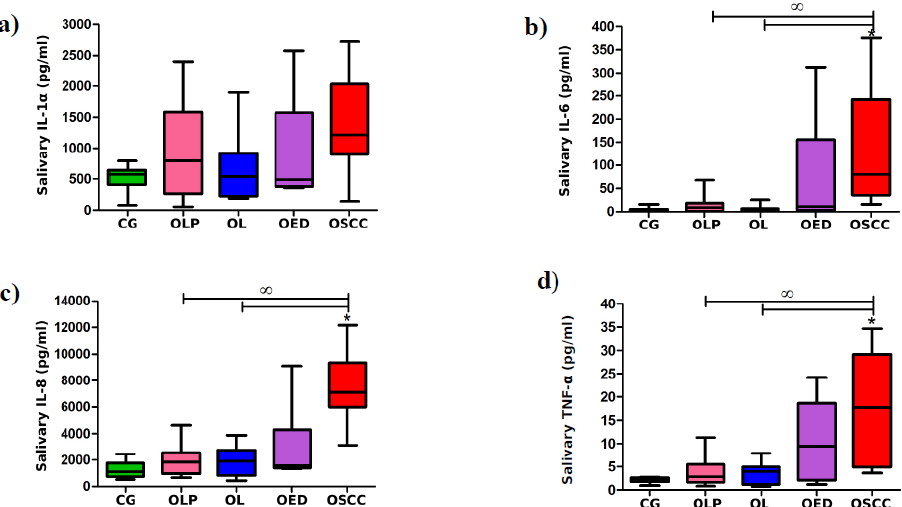
Figure 9. Salivary levels of IL-1 α ( a ), IL-6 ( b ), IL-8 ( c ), and TNF- α ( d ) in control group (CG) and patients with oral lichen planus without dysplasia (OLP), oral leukoplakia without dysplasia (OL), oral epithelial dysplasia (OED), or oral squamous cell carcinoma (OSCC); the median and interquartile range (box), and percentile 5–95% range (whiskers) are shown; * means significant di ff erence vs. CG; ∞ means significant di ff erence vs. OSCC ( p < 0.05).